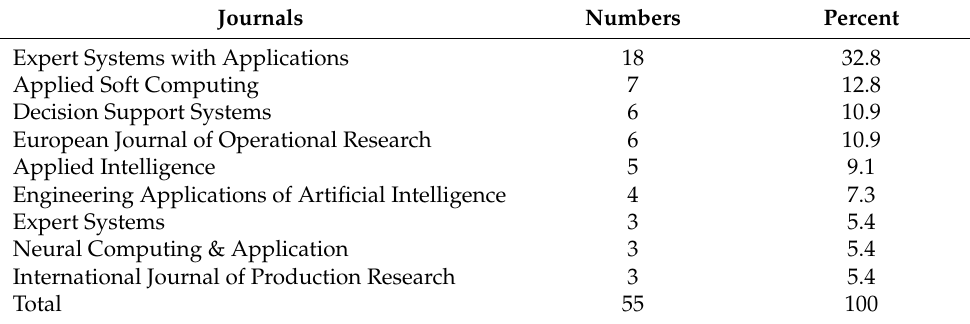
Table 3. Distribution of articles based on